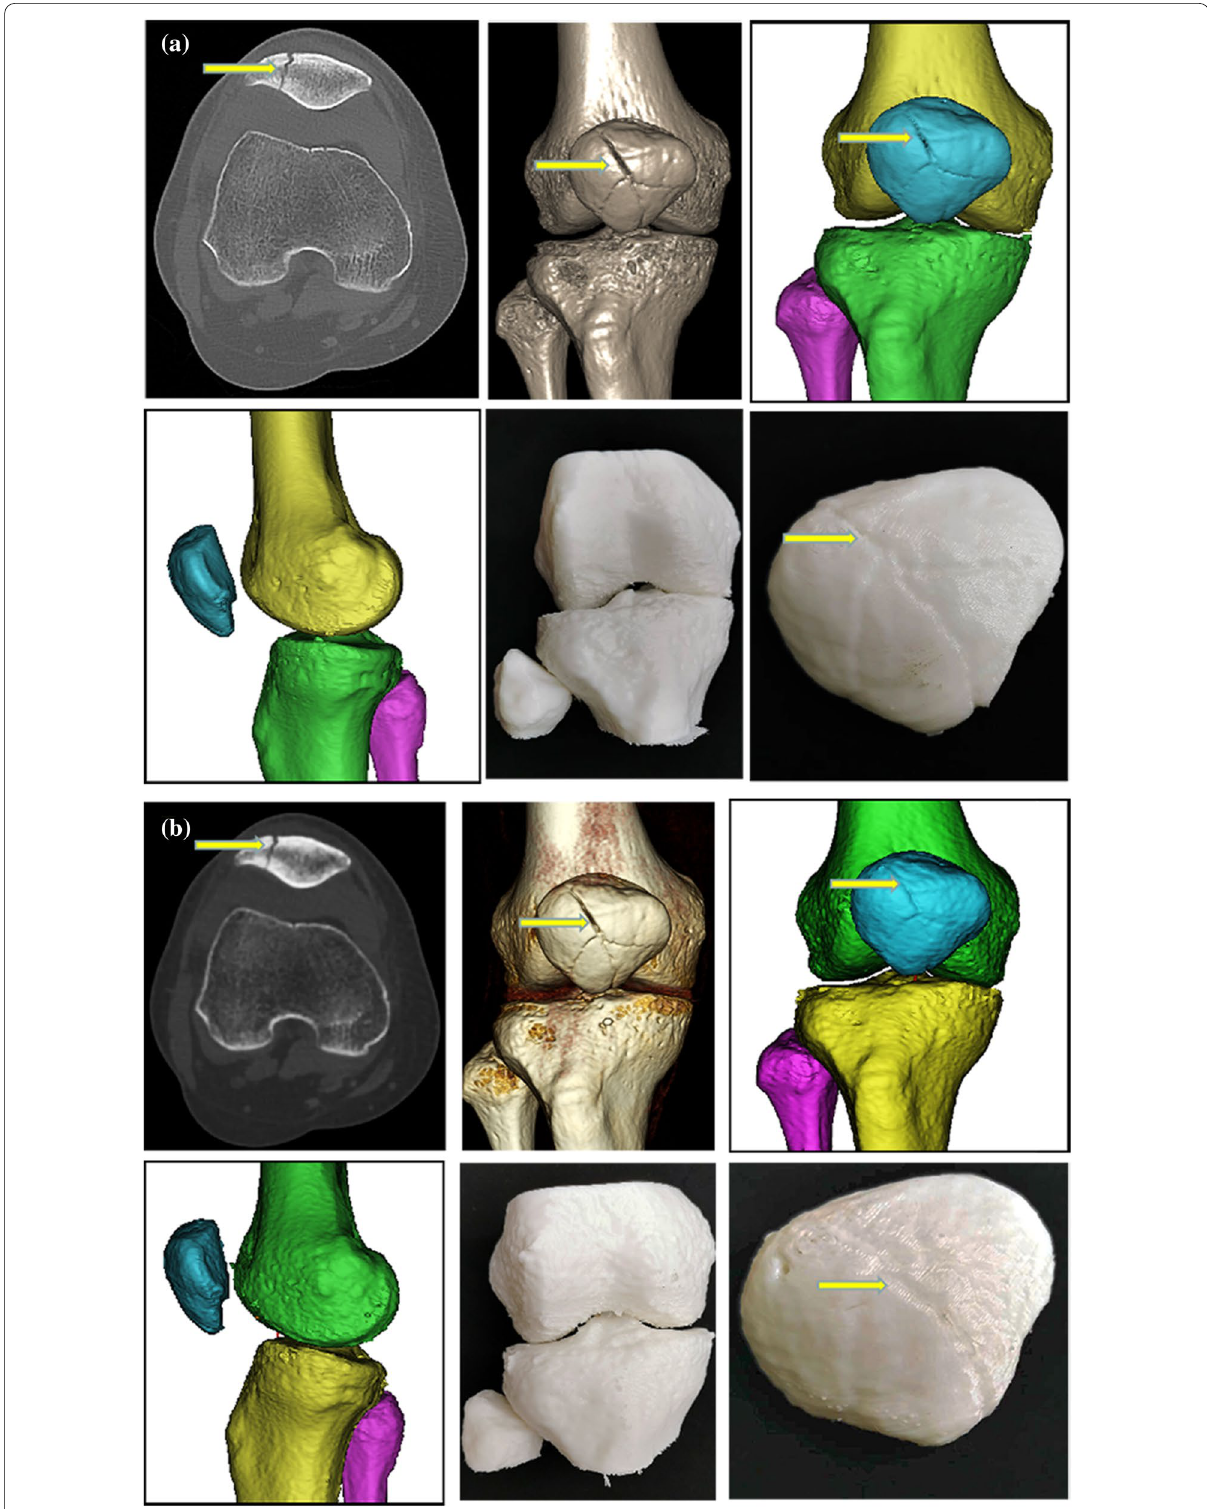
Fig. 3 (See legend on previous